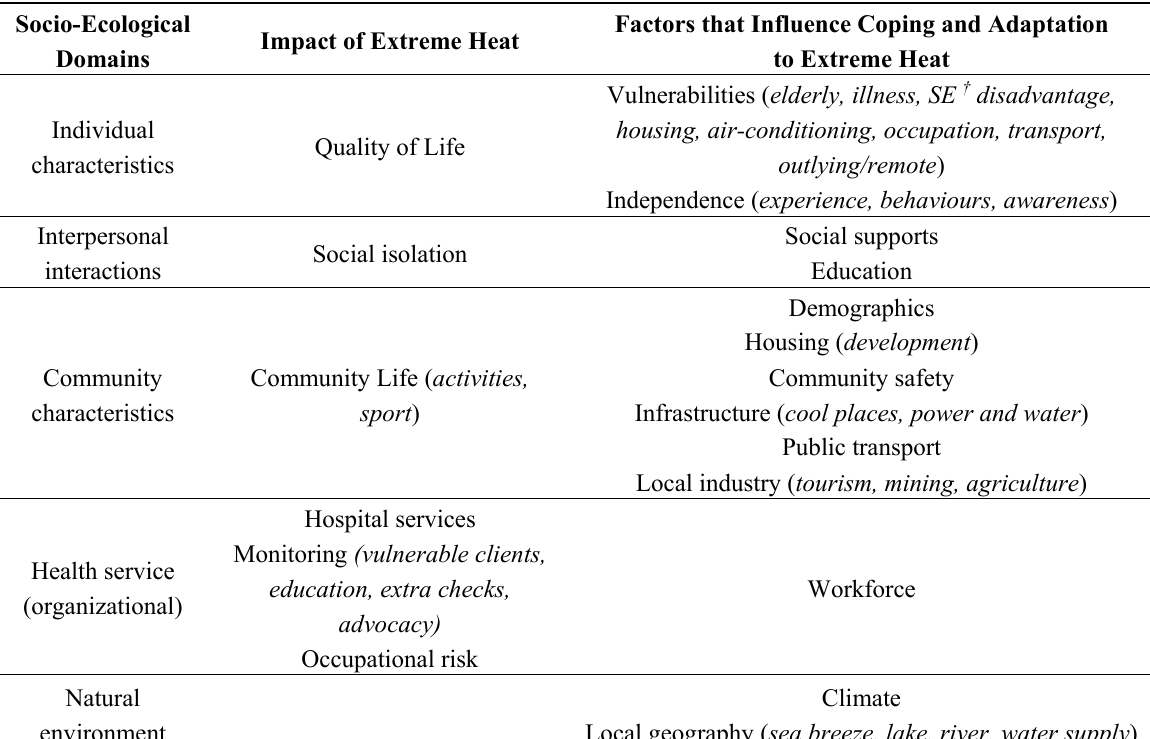
Table 2. Identified themes and sub-themes assigned to five socio-ecological